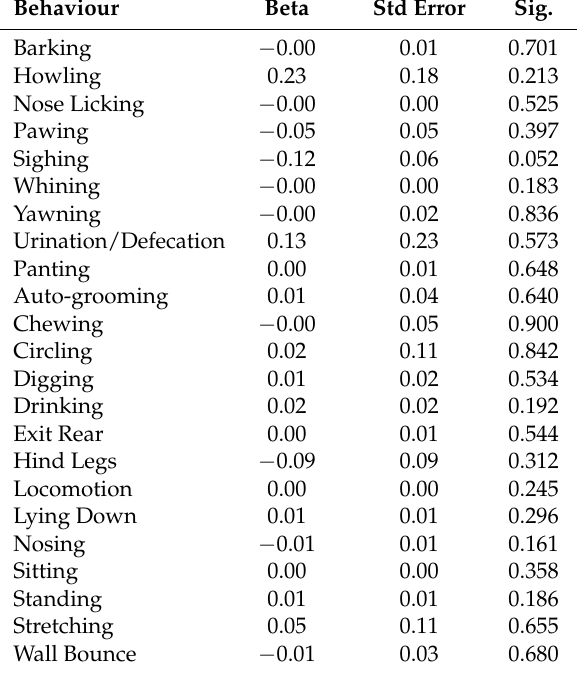
Table 4. Results of the multivariate regression